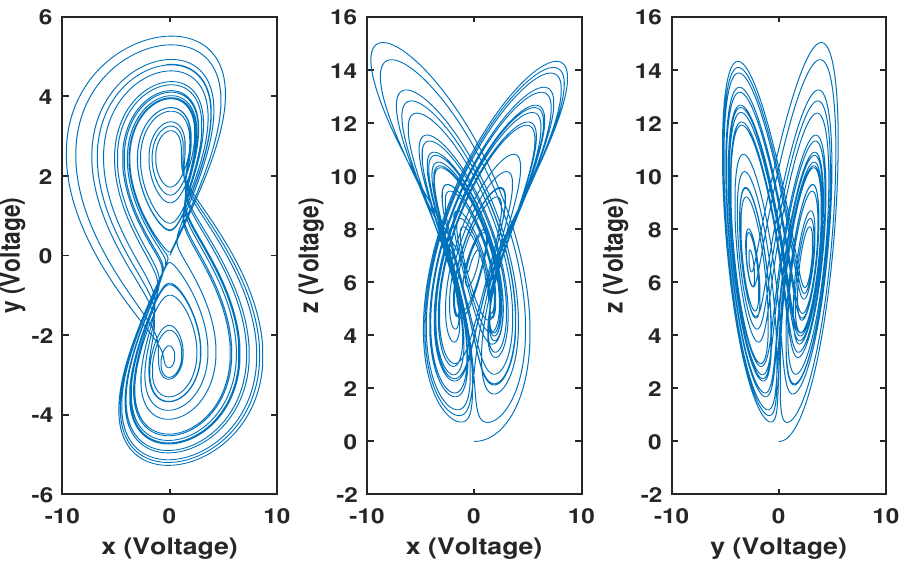
Figure 4. Chaotic oscillator of 2.85-order Rucklidge system by Multisim. 3. Anti-Synchronization of Coupled Nonidentical Fractional-Order Rucklidge